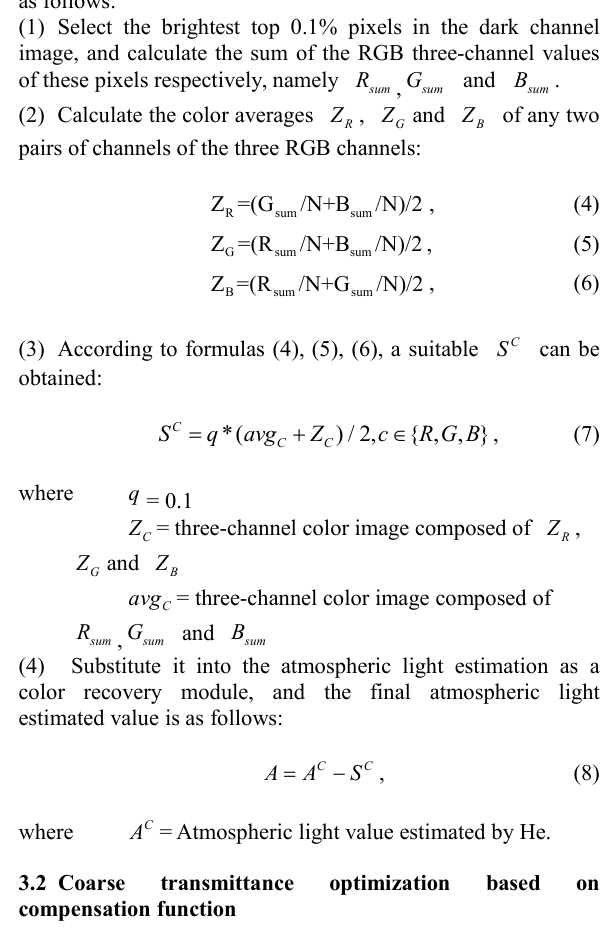
Z = three-channel color image composed C